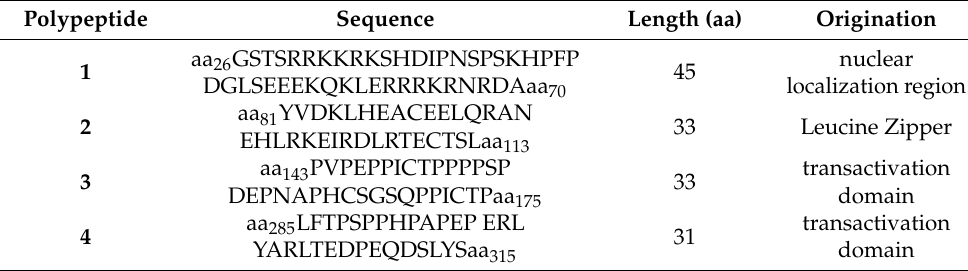
Table 1. Sequences of Meq polypeptides synthesized for making